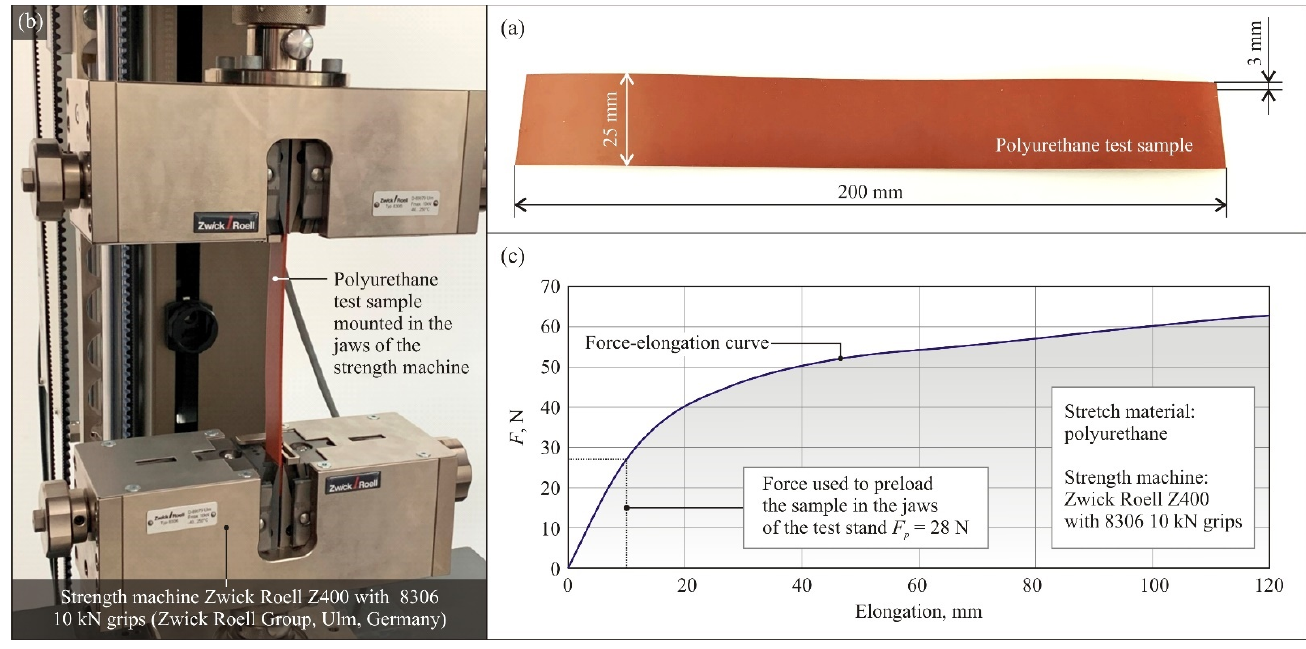
Figure 4. General view of test sample made of polyurethane ( a ), the strength characteristics of which ( c ) were determined by axial tensile test on a Zwick Roell strength machine Z400 8306 with 10 kN grips (Zwick Roell Group, Ulm, Germany) ( b